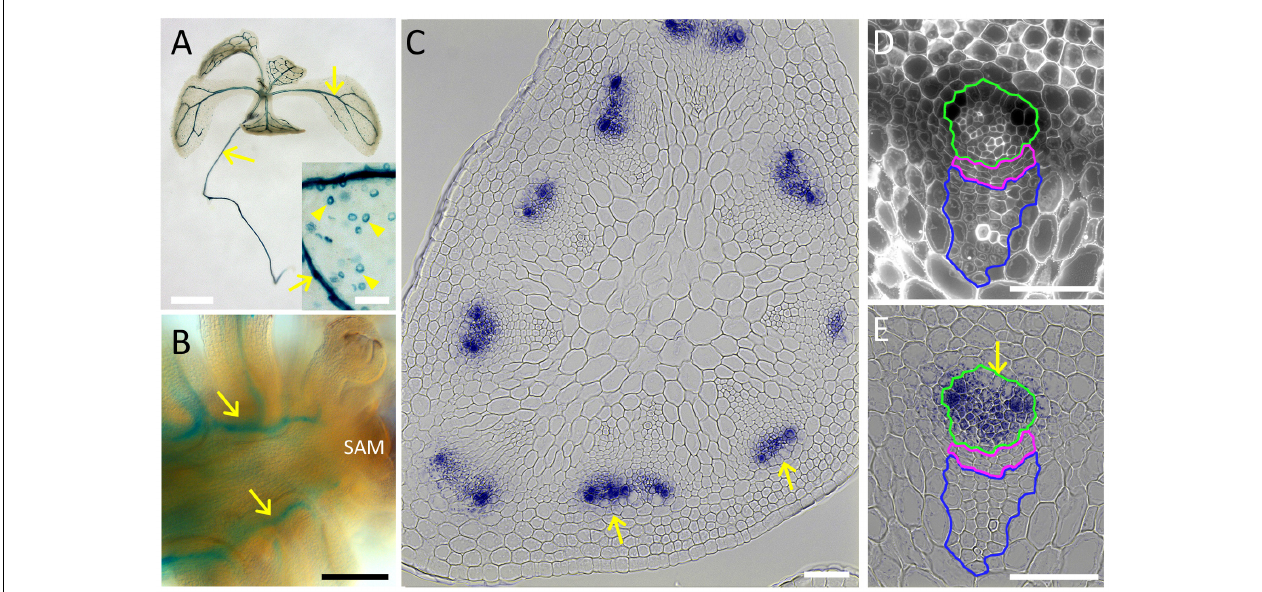
FIGURE 1 | PLL12 is expressed in the stem phloem. (A,B) : pPLL12:PLL12:GUS seedling (A) and inflorescence apex (B) stained for GUS and cleared with chloral hydrate, showing GUS activity in the vasculature (arrows); in panel (A) , note also the dotted signal on cotyledons due to expression in stomatal guard cells. Bars: 1 cm (A) , 500 µ m (B) . (C–E) : Cross-section of the inflorescence stem showing pPLL12:PLL12:GUS expression in phloem cells; (C) : overview of a stem section, with GUS staining in part of the vascular bundles (arrows); (D) : calcofluor-stained section through a single vascular bundle, with the phloem, cambium and xylem regions enclosed in green, magenta, and blue lines, respectively; (E) : same section as in panel (D) , showing GUS staining specifically in the phloem (arrow); bars: 50 µ m.